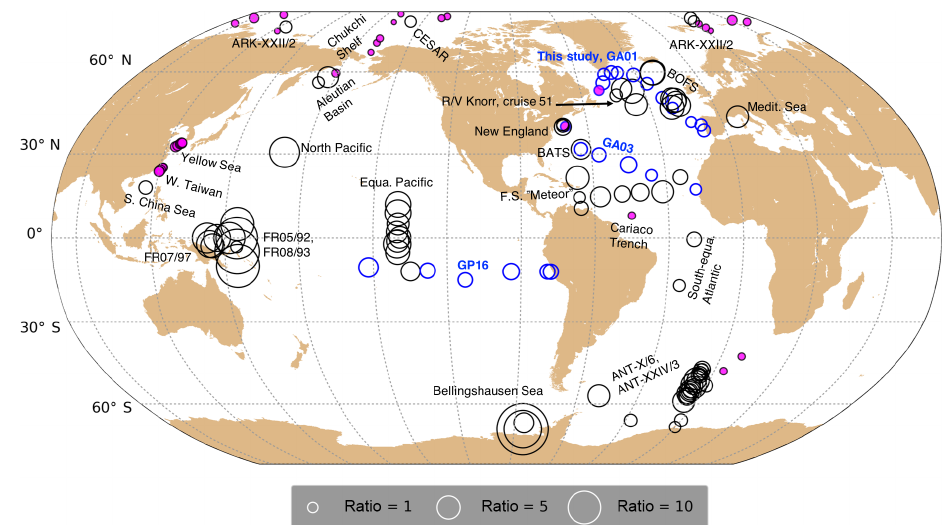
Figure 8. Comparison of particulate 210 Po / 210 Pb activity ratios in the upper 200m from this study and 20 previous studies (references in Table 2). Information about the study site, sampling date, method, and particle size of each study is shown in Table 2. The black circles represent data from previous studies, while the blue circles are the results from samples analyzed at QC from three recent GEOTRACES transects (GA03; GP16; and this study: GA01 GEOVIDE). The filled magenta and open circles indicate activity ratios lower and higher than 1,